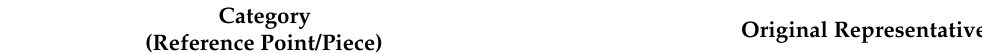
Table 7. Open coding